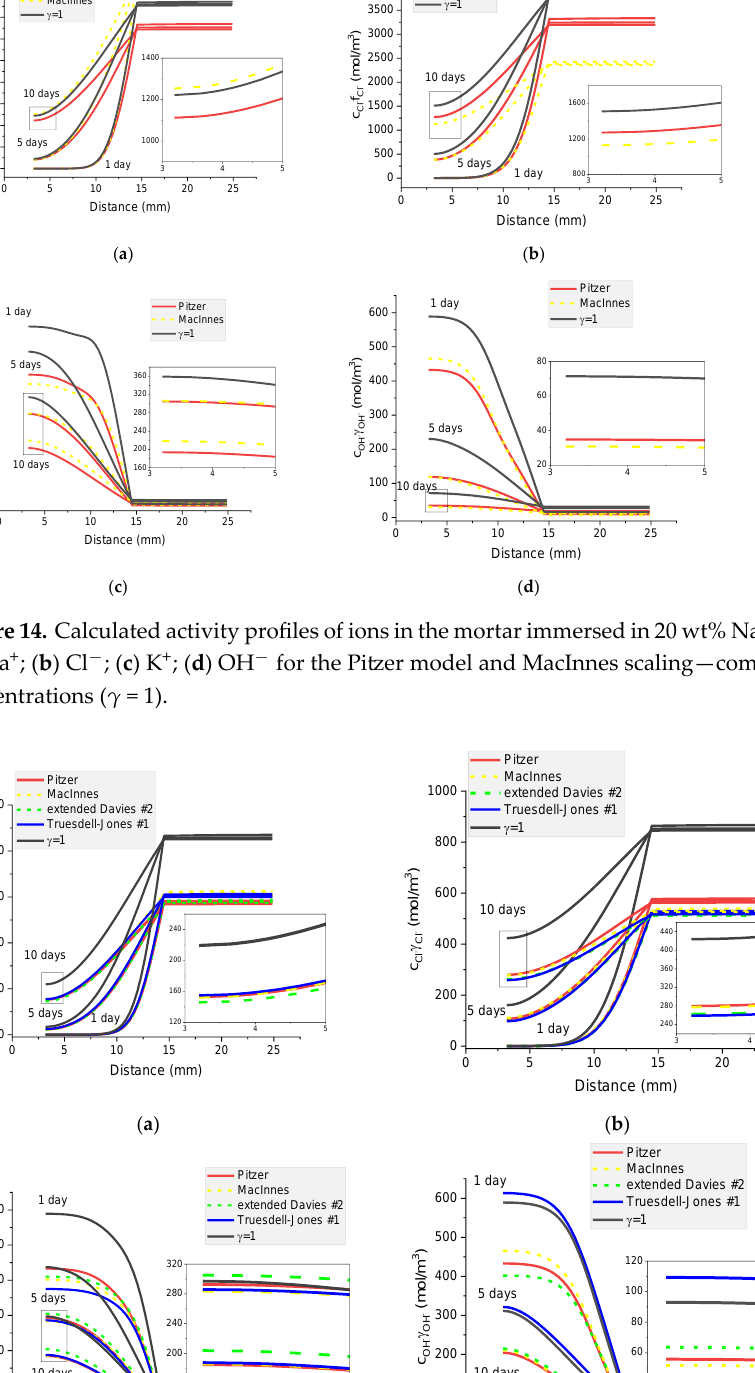
Figure 15. Calculated activities profiles of ions in the mortar immersed in 5 wt% NaCl water solu- tion. ( a ) Na + ; ( b ) Cl − ; ( c ) K; ( d ) OH − For the Pitzer model, MacInnes scaling, extended Davies and Truesdell – Jones models — comparison with ions concentrations ( γ = 1).